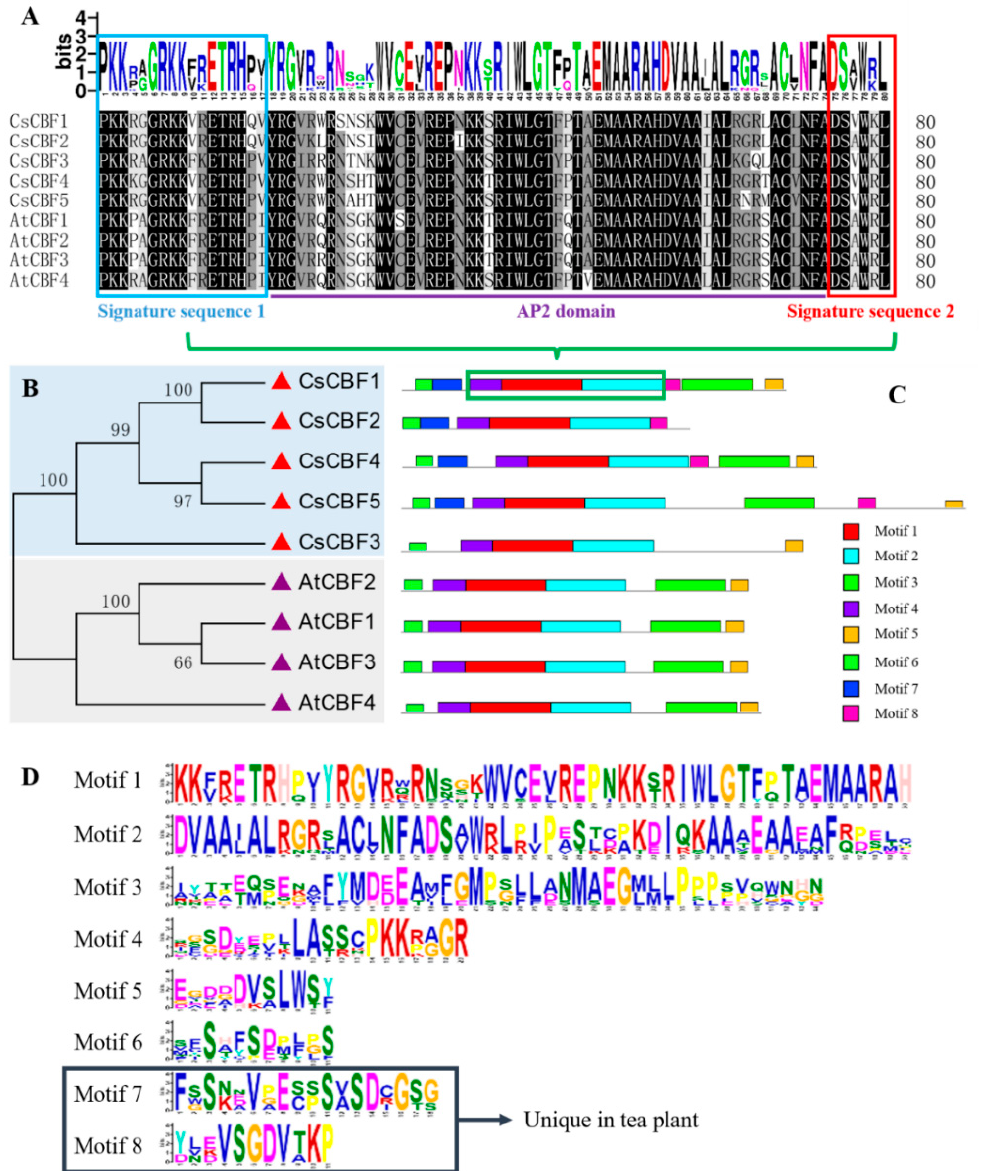
Figure 1. Sequence alignment, phylogenetic and conserved motif analysis of CsCBFs and AtCBFs. ( A ) Multiple sequence alignment of the AP2 DNA-binding domain and two signature sequences and generating a logo. The Y axis (measured in bits) of logo depicts the overall height of the stack, indicating the sequence conservation at that position, while the height of symbols within the stack indicates the relative frequency of each amino at that position. The purple underline indicates the AP2 DNA-binding domain; the blue box represents the PKK / RPAGRxKFxETRHP signature sequence, and the red box represents the DSAWR signature sequence. ( B ) Phylogenetic analysis of the CBF protein sequences from tea plants and Arabidopsis. The red triangle represents the tea plants and the purple triangle represents the Arabidopsis. The phylogenetic tree was constructed using MEGA 5.0 software and the Neighbor-Joining method. The number above / below the branch represents the bootstrap values (from 1000 replicates). ( C ) Eight conserved motifs were predicted by MEME. ( D ) Detailed information of the eight conserved motifs.